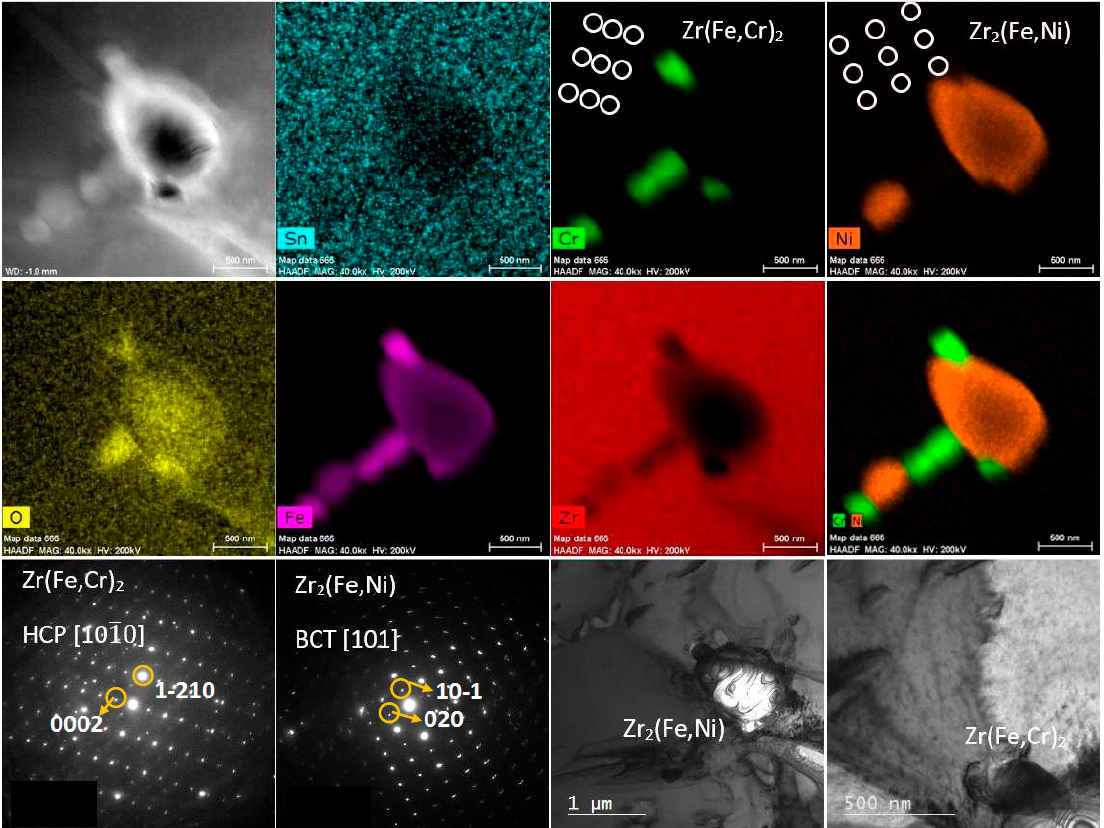
Figure 2. STEM-EDS elemental mapping on intermetallic precipitates present in Zircaoy-2. Corresponding selected-aperture electron diffraction pattern (SAEDP) and TEM bright field micrographs are given. Each micrograph of precipitates is labelled for it chemistry and shows crystallinity from SAEDP. The diffraction patterns well indicated that Zr(Fe,Cr) 2 particles are in hexagonal close-packed (HCP) structure (HCP) structure and Zr 2 (Fe,Ni) particles are in body-centred tetragonal (BCT) structure. The scale bar in element maps is 500 nm.